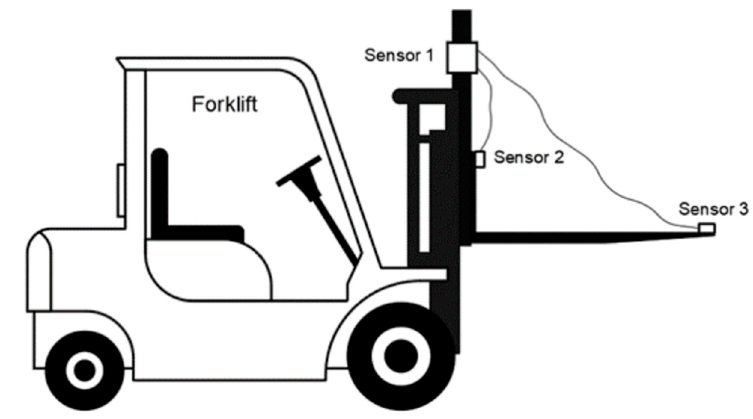
Figure 3. Sensor locations for vibration data collection.